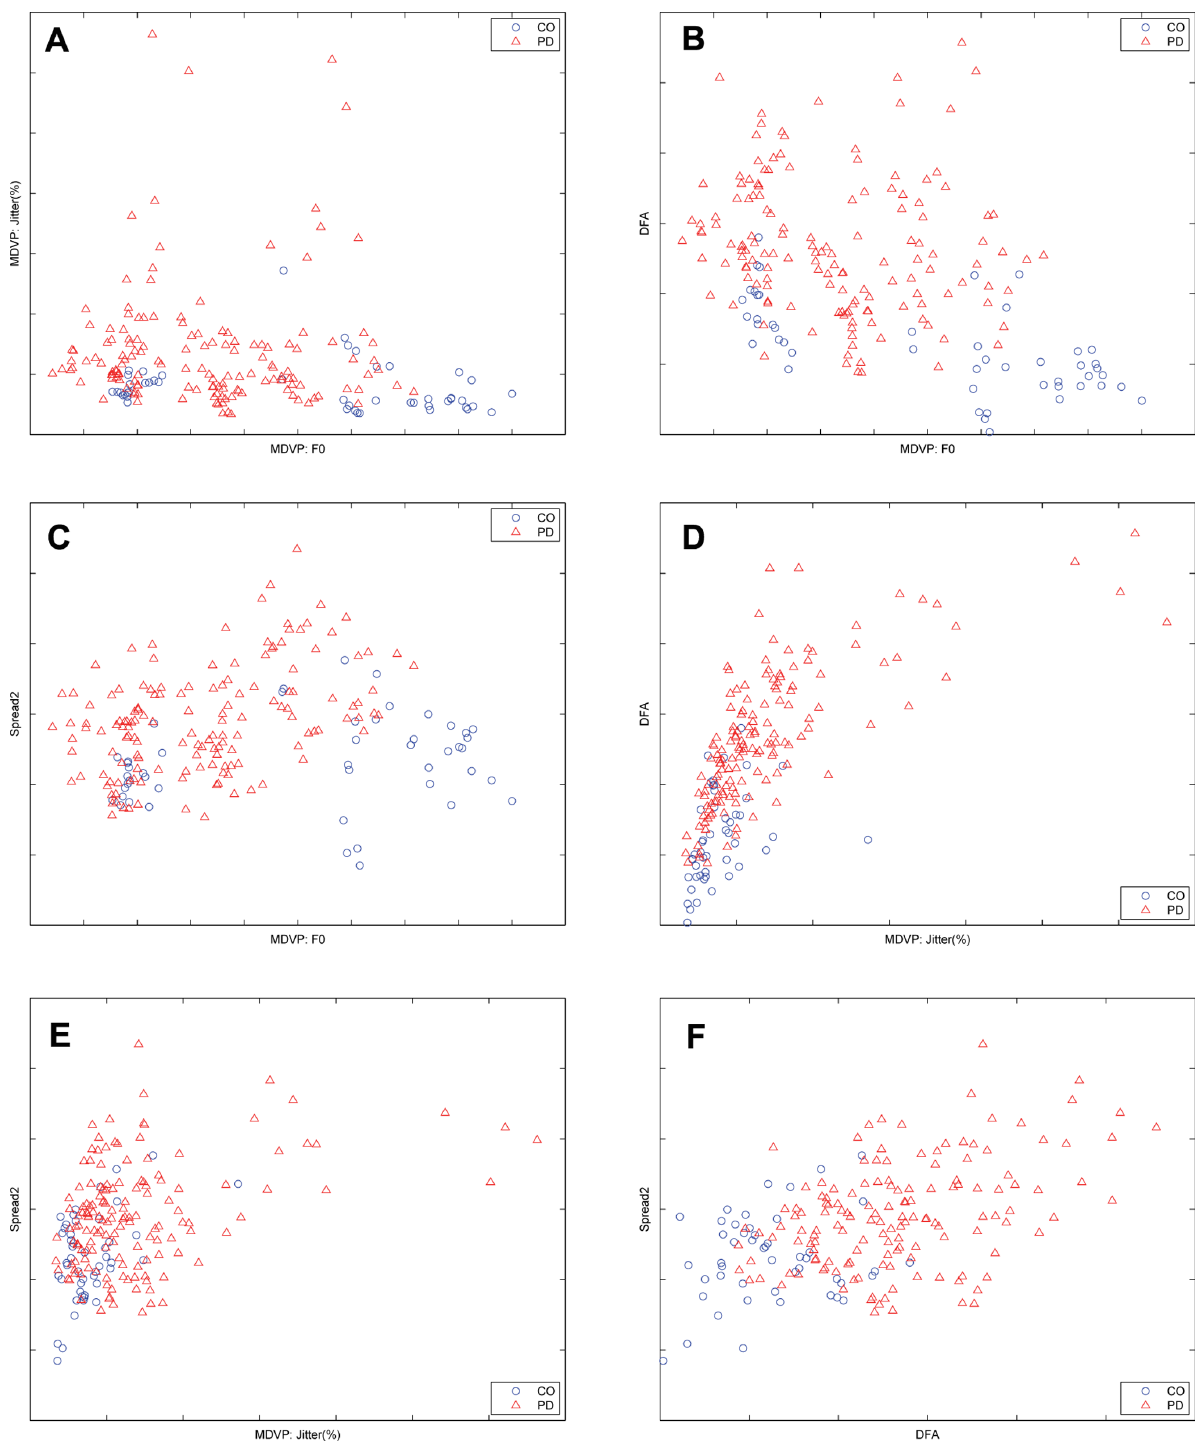
Figure 6. Scatter plots of the vocal patterns associated with the healthy controls (CO) and patients with Parkinson’s disease (PD) in the two- dimensional feature spaces of ( A ) MDVP: F0 and MDVP: Jitter (%), ( B ) MDVP: F0 and detrended fluctuation analysis (DFA), ( C ) MDVP: F0 and Spread2, ( D ) MDVP: Jitter (%) and DFA, ( E ) MDVP: Jitter (%) and Spread2, and ( F ) DFA and Spread2, respectively.